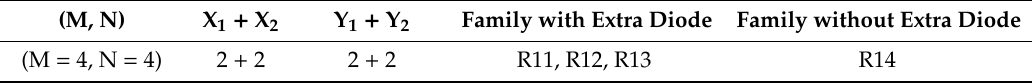
Figure 23. Four topologies derived from MN principle under DFUSPWM. ( a ) R11 (new); ( b ) R12 (new); ( c ) R14 [17]. Table 7. Two topological families from MN principle under DFUSPWM.